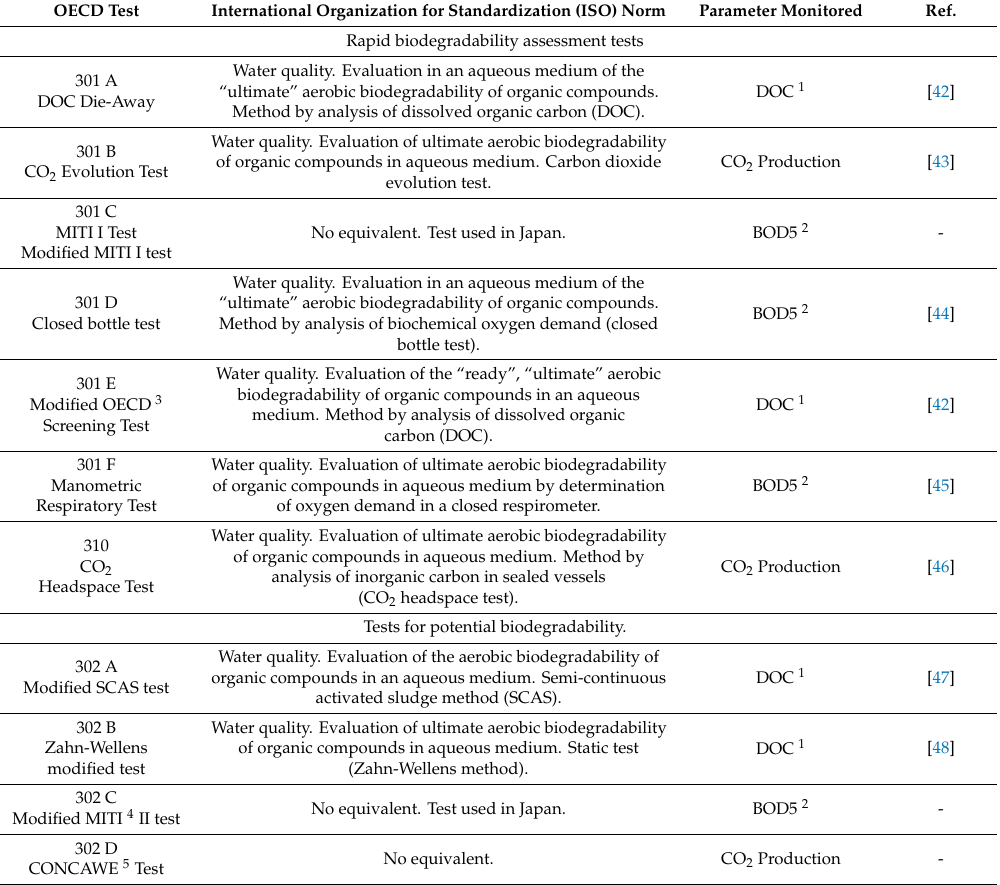
Table 3. Tests used to assess the rapid and potential aerobic biodegradability of various materials / chemical compounds in water